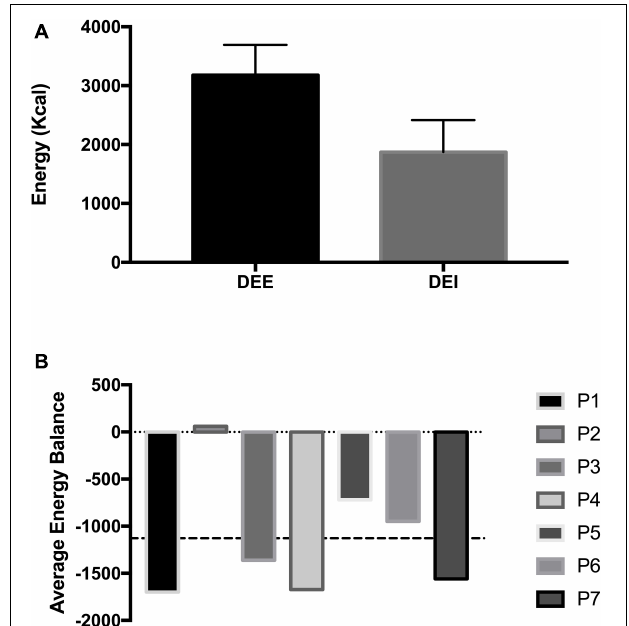
FIGURE 3 | Panel (A) shows the mean daily energy expenditure (DEE) measured via DLW and mean daily energy intake (DEI) of saturation divers during a commercial operation in the North Sea. Panel (B) shows the individual energy balance (DEE–DEI) with commercial saturation divers. The dashed line represents the mean energy